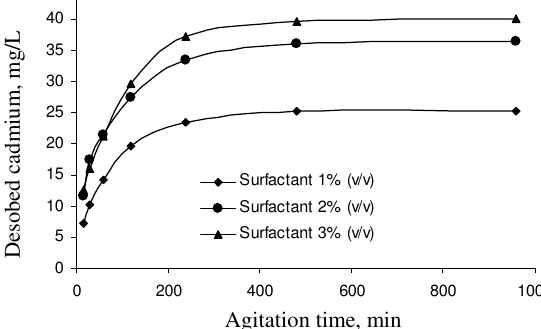
Figure 2. Cadmium desorbed in surfactant solution sorbate strength = 100 mg/L; pH=6